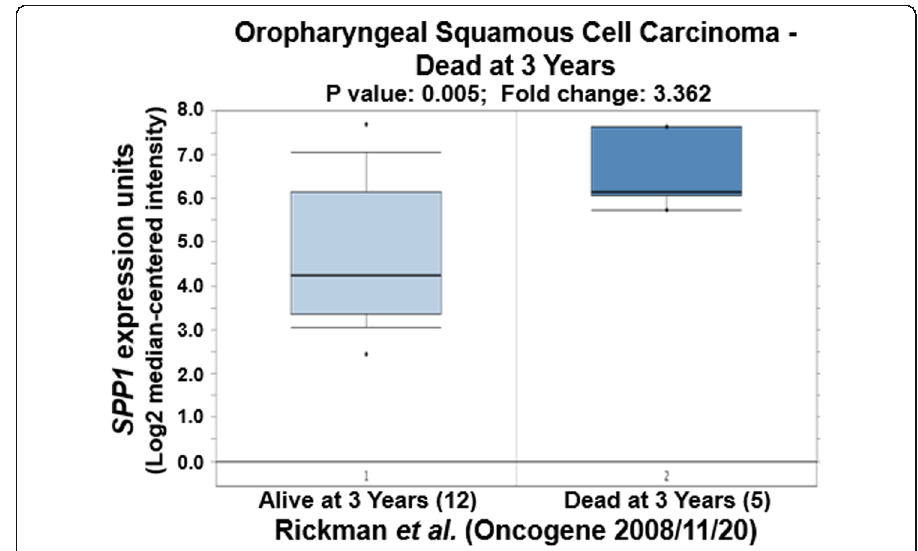
Fig. 9 Comparison of SPP1 expression in oropharyngeal squamous cell